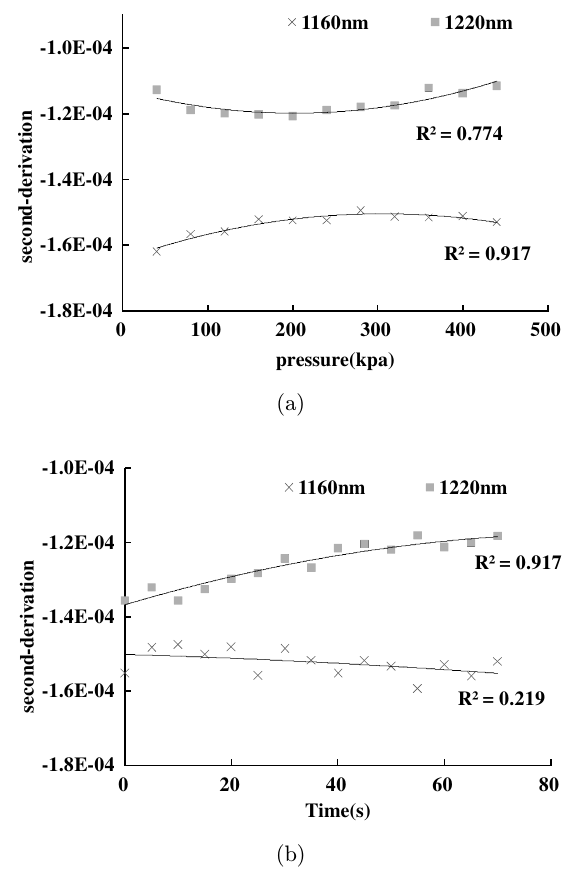
Fig. 8. Variations of bulk and bound water with (a) pressure increased and (b)